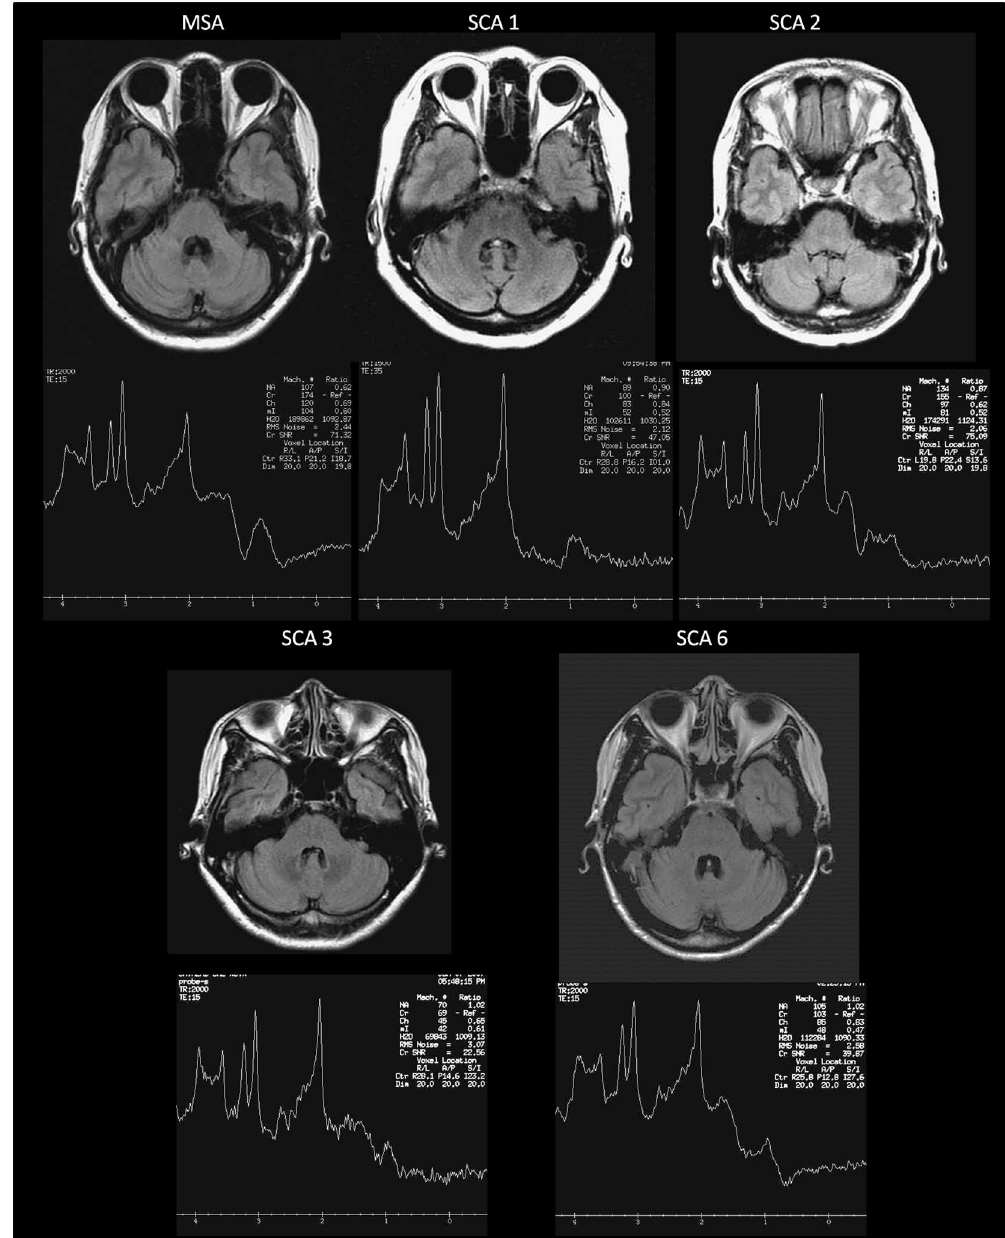
Figure 1. Axial FLAIR images at pons level and cerebellar MRS of patients with MSA or